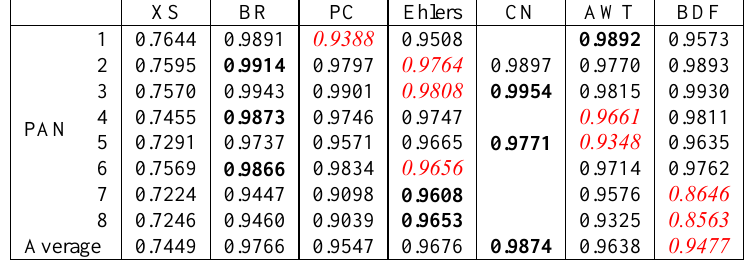
Table 9. LCC between Worldview-2 panchromatic and fused images using different algorithms